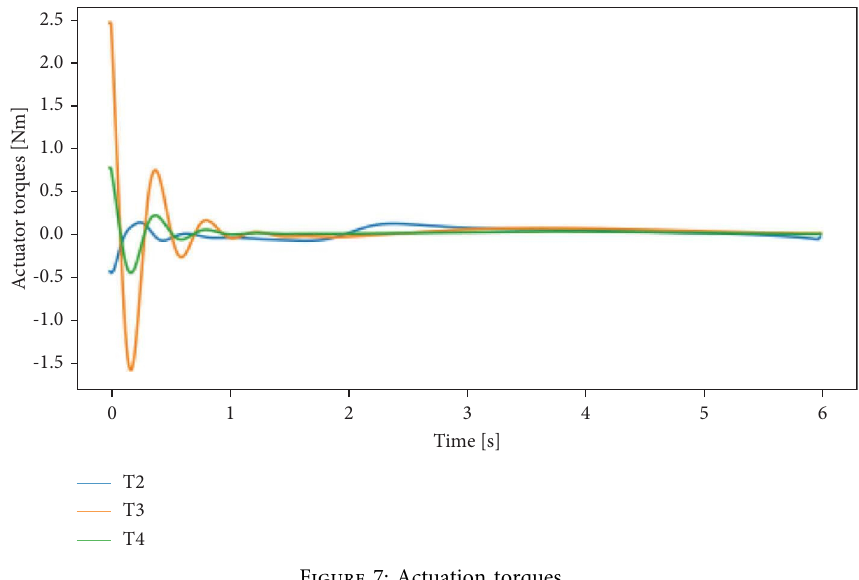
Figure 7: Actuation torques.